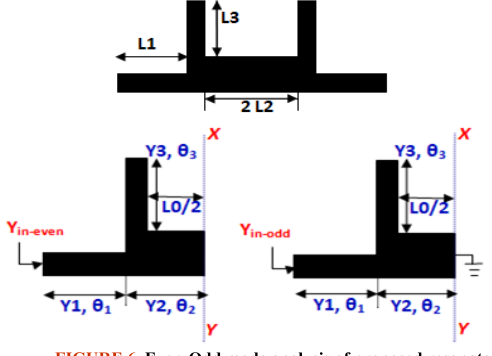
FIGURE 5. RM2 and RM3 merge at 5.3 GHz